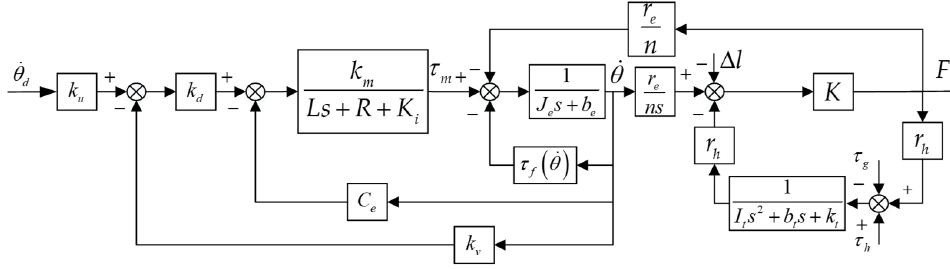
Figure 4. The block diagram of the inner loop [31].